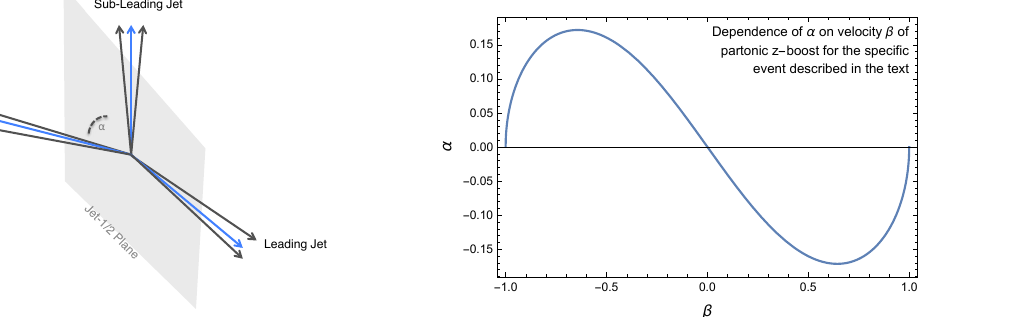
Figure 1 . Illustration of the de(cid:12)nition of (cid:11) in a three-jet system, where the leading jet is de(cid:12)ned as the jet with the highest p T .